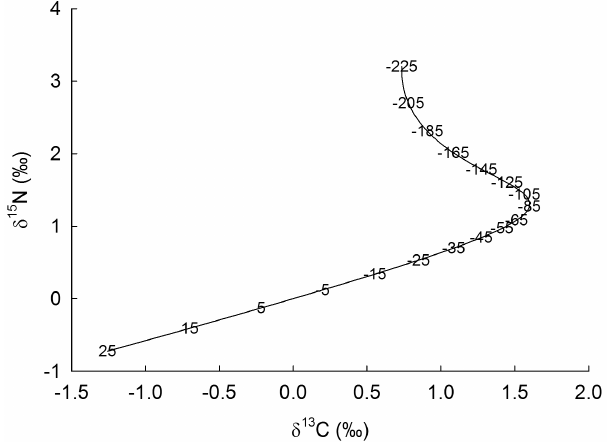
Figure 5. Plot coefficients of δ 15 N and δ 13 C from regression mod- els in peat profiles, as calculated from Table 1. The plot number is the symbol for the paired coefficient values. For clarity, plots with identical or near-identical values are indicated with